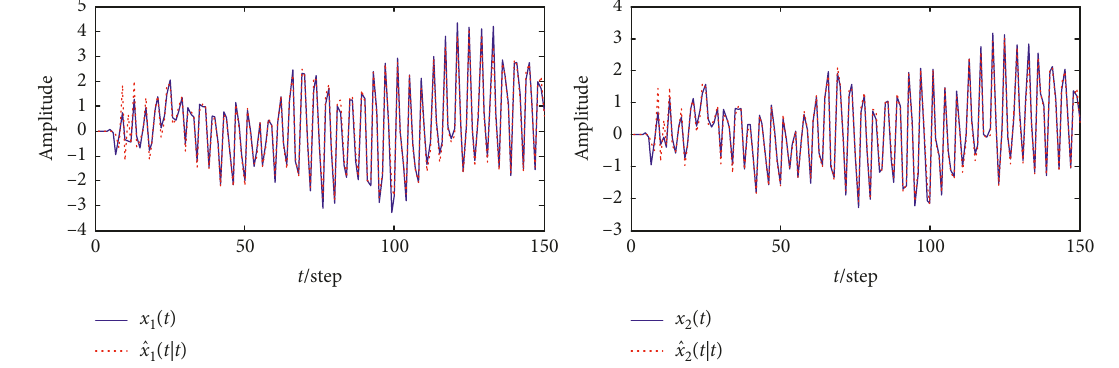
Figure 1: Tracking performance of the state